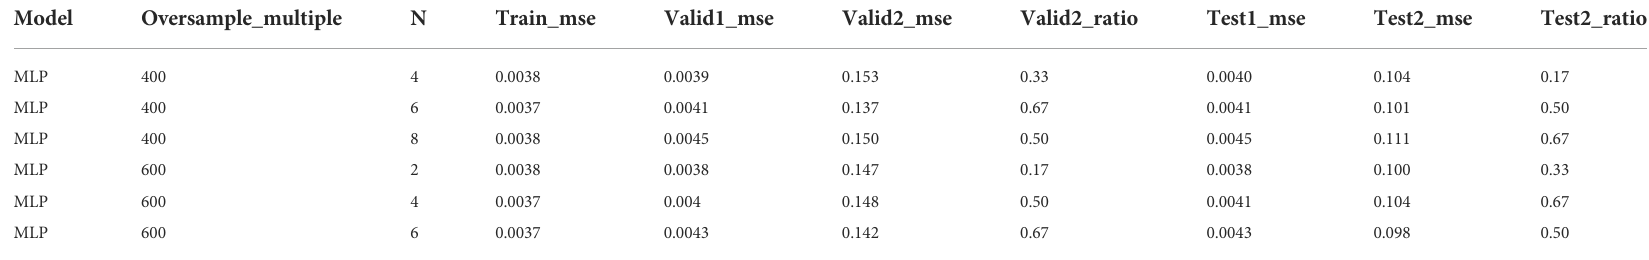
TABLE 1 The performance of MLP with representative undersampling interval N and repeated sampling multiples (complete data were provided in supporting information). Model